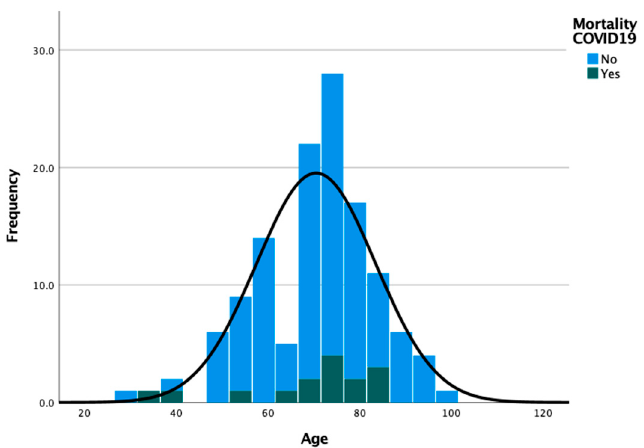
Figure 5. Distribution of patients by age groups and COVID-19 mortality.